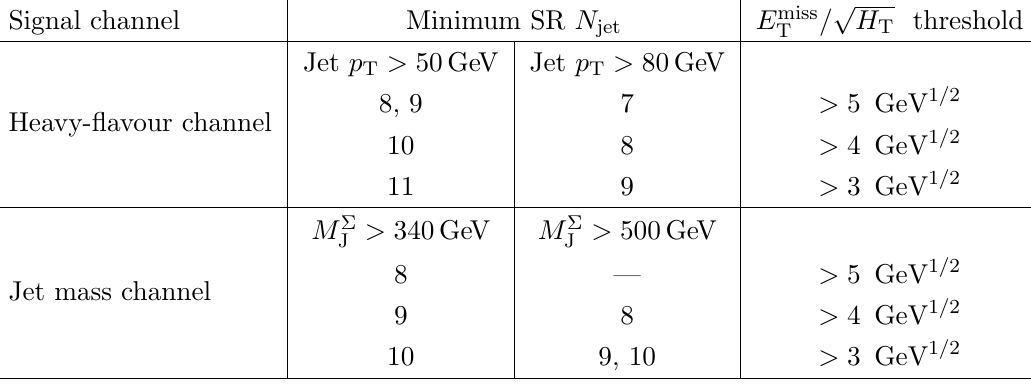
p Table 3. The E miss = H T thresholds for the control regions corresponding to each signal T